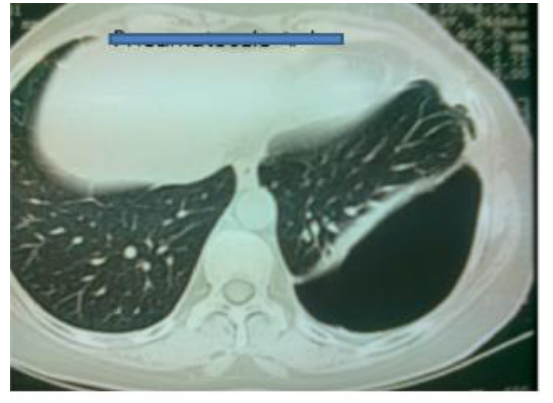
course. Figure 1: Chest CT revealed large